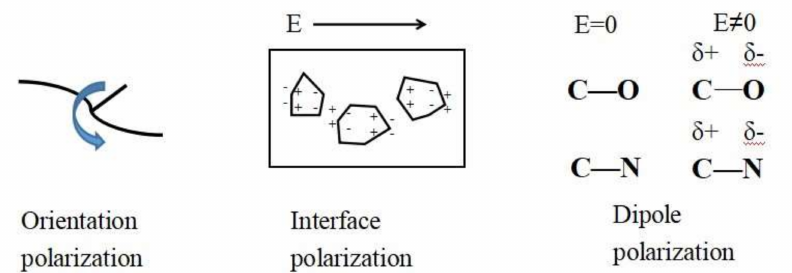
Figure 8. Schematic of the irradiation process and irradiation degradation process of PI repeat unit and the XPS results show that the content of C = O and C–N decrease and the content of C–C and C–O increase.